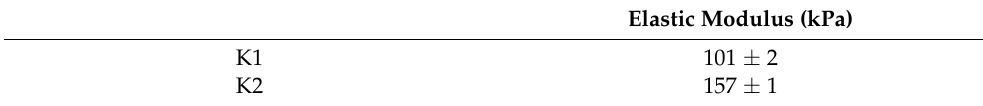
Table 3. Modulus of elasticity of composite materials K1 and K2.